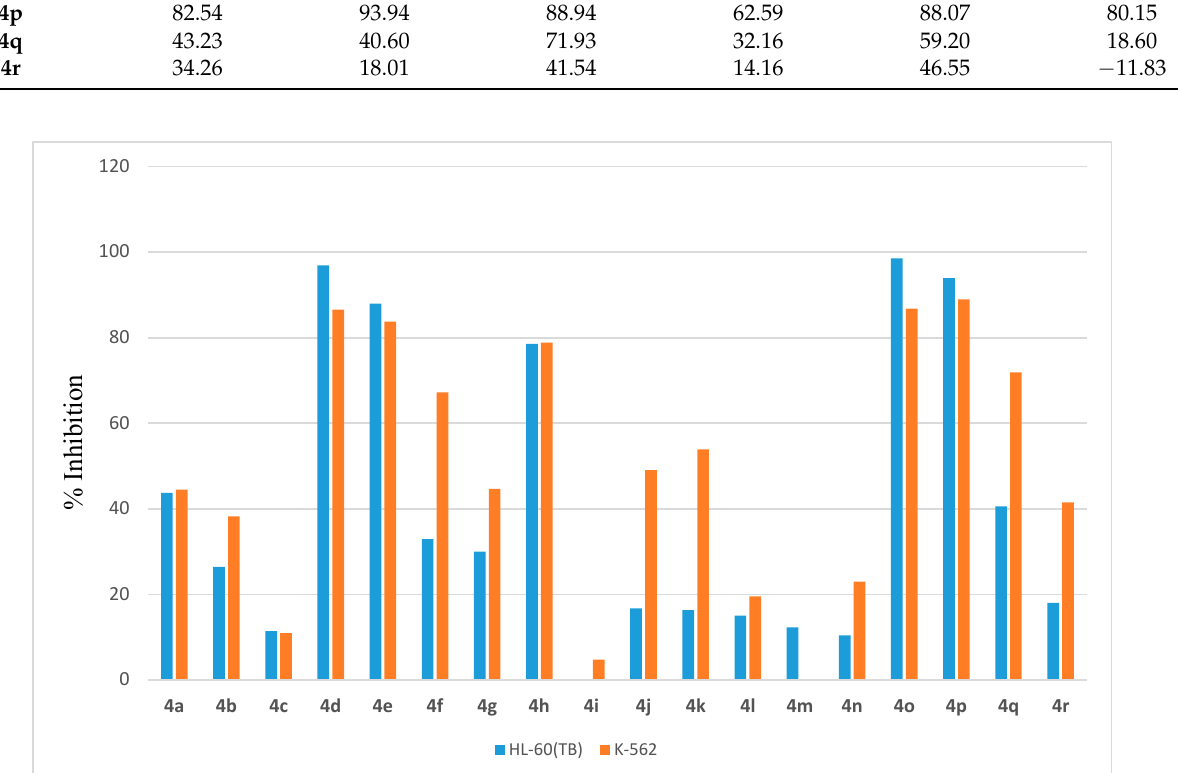
Figure 5. Mean % inhibition of the target compounds 4a ‒ r against leukemia cell lines (HL-60(TB) and K-562).